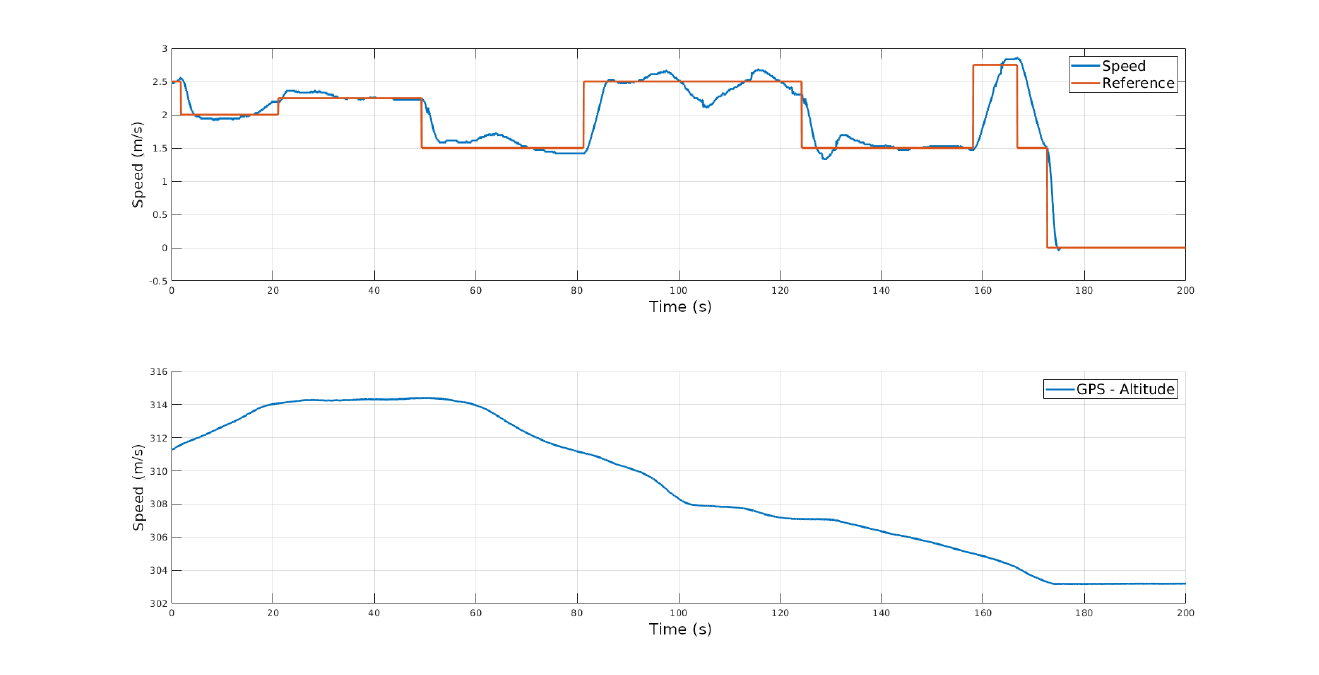
Figure 19. Low-level control speed downhill.